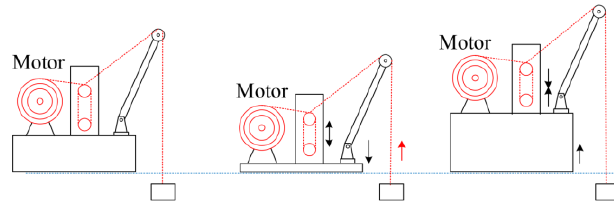
Figure 2. Hydraulic cylinder telescopic type [12].